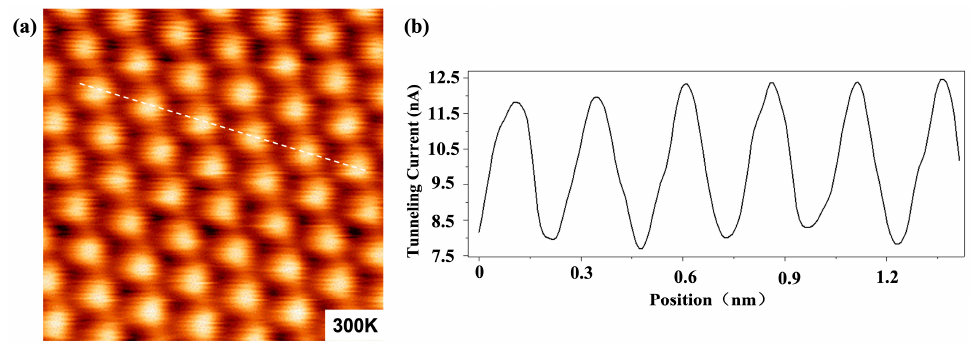
Figure 3. ( a ) Atomic-resolution STM image of HOPG taken in constant height mode at 300 K in a cryogen-free superconducting magnet. Scan area = 1.7 nm × 1.7 nm, bias voltage = + 200 mV, and average tunneling current = 10 nA. ( b ) Cross-sectional profile along the white dashed line.